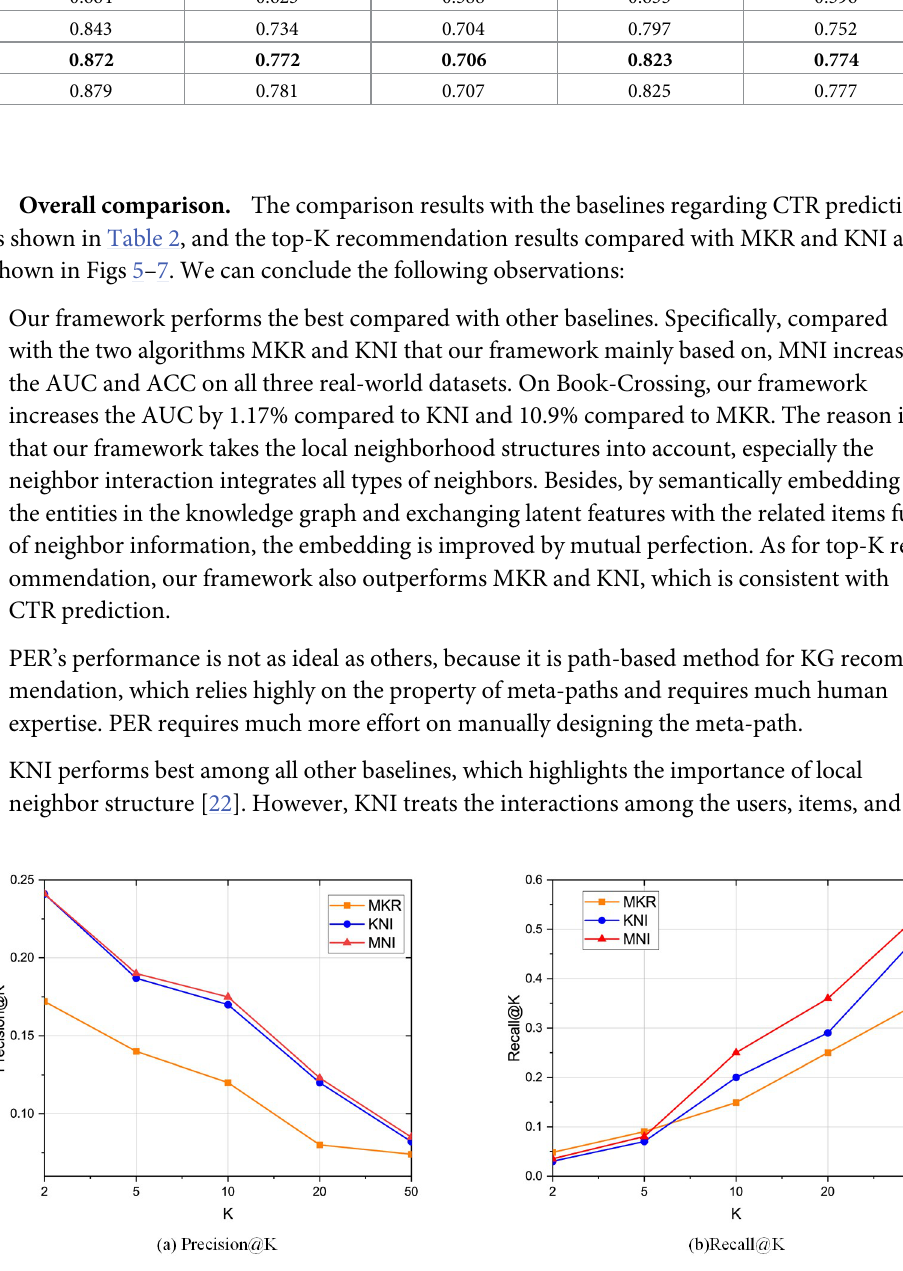
Fig 5. Top K recommendation result for Movielens-1M regarding precision and